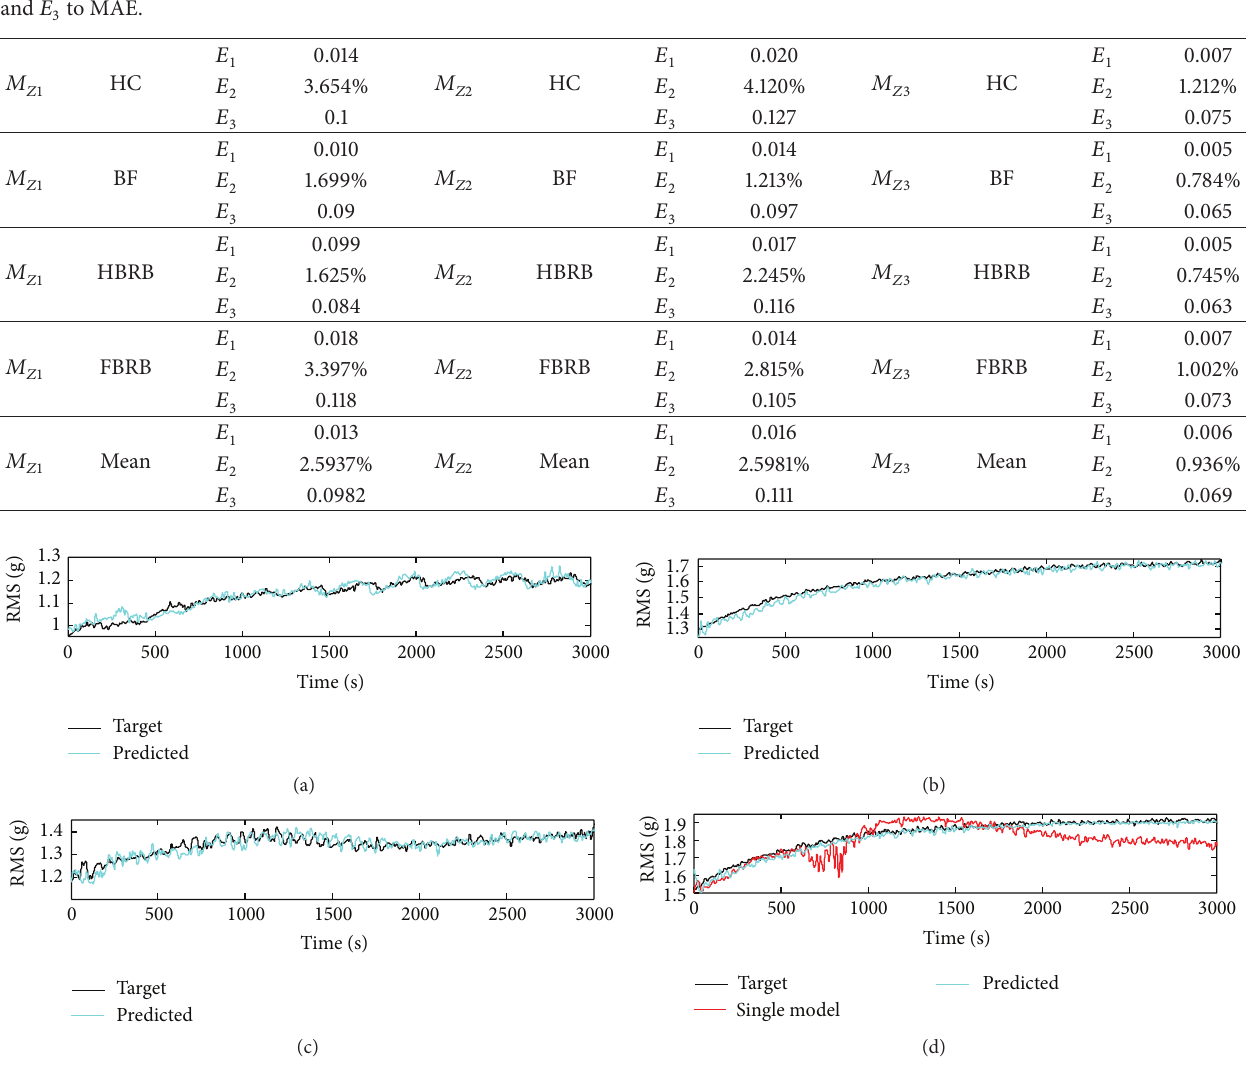
Table 3: Error achieved by the model with the four different sets used in the experimental validation. 𝐸 1 corresponds to RMSE, 𝐸 2 to MAPE, and 𝐸 3 to MAE.